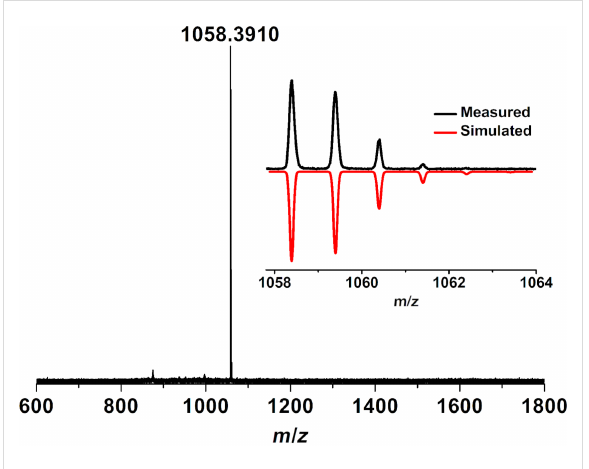
Figure 1: High-resolution MALDI-TOF mass spectrum of 1 . Inset: isotopic distribution compared to mass spectrum simulated for C 84 H 50